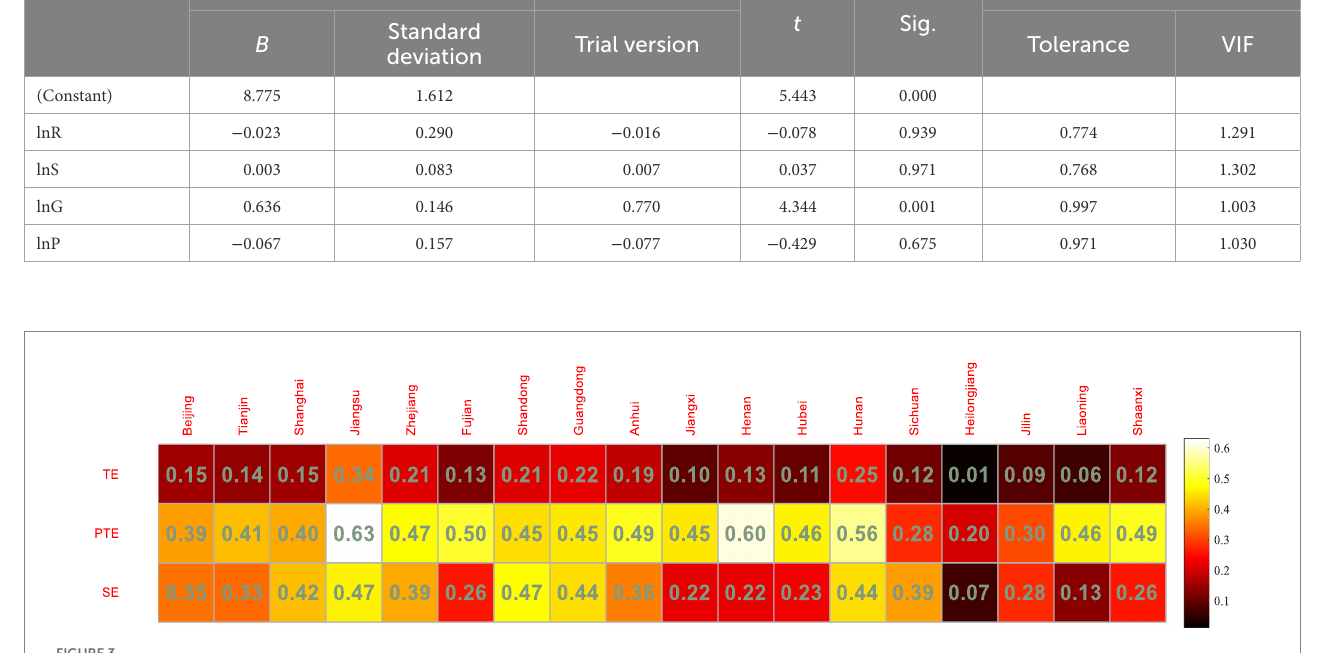
FIGURE 3 Three-stage DEA evaluation of technology and finance in strategic emerging